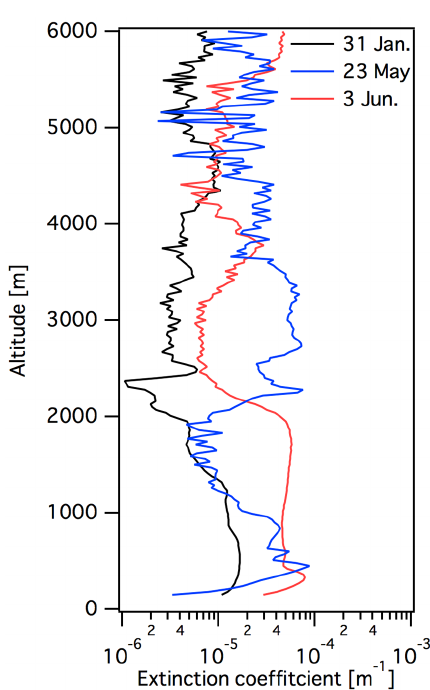
Figure 12. Vertical profiles of aerosol extinction coefficients for al- titudes from 0 to 6km, as obtained from lidar measurements for the case studies. Data for 0 to 150m are not